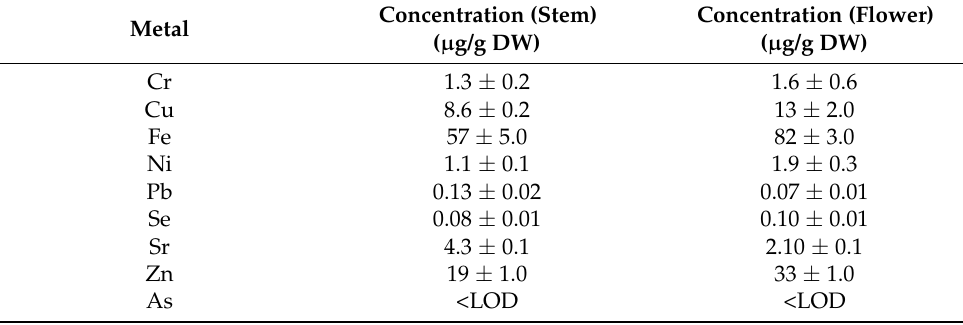
Table 1. Contents of selected metals in H. italicum aerial parts.